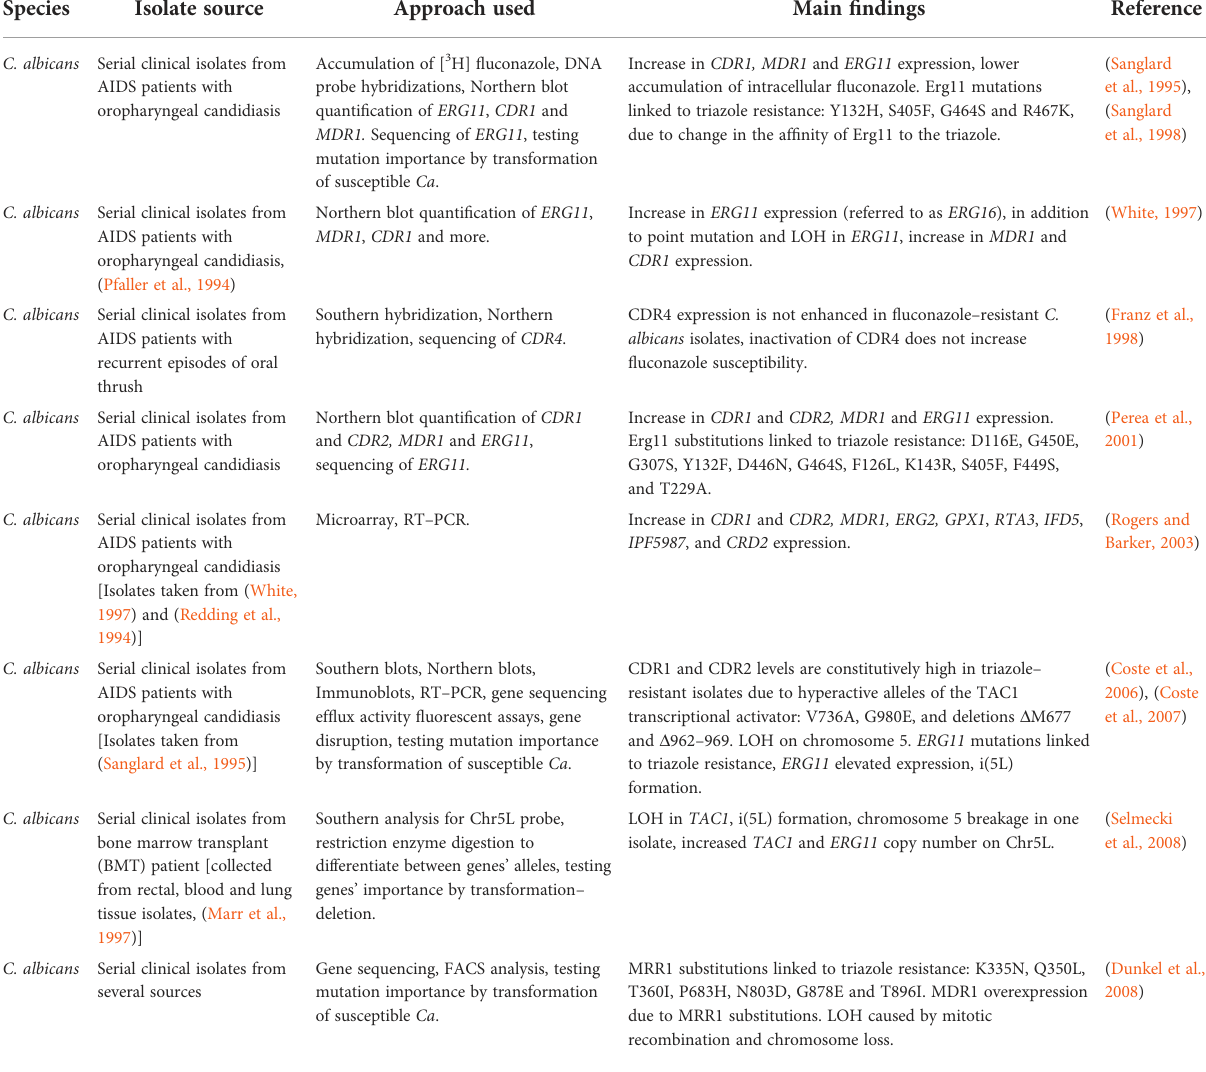
TABLE 2 Development of triazole resistance in serial clinical isolates of Candida